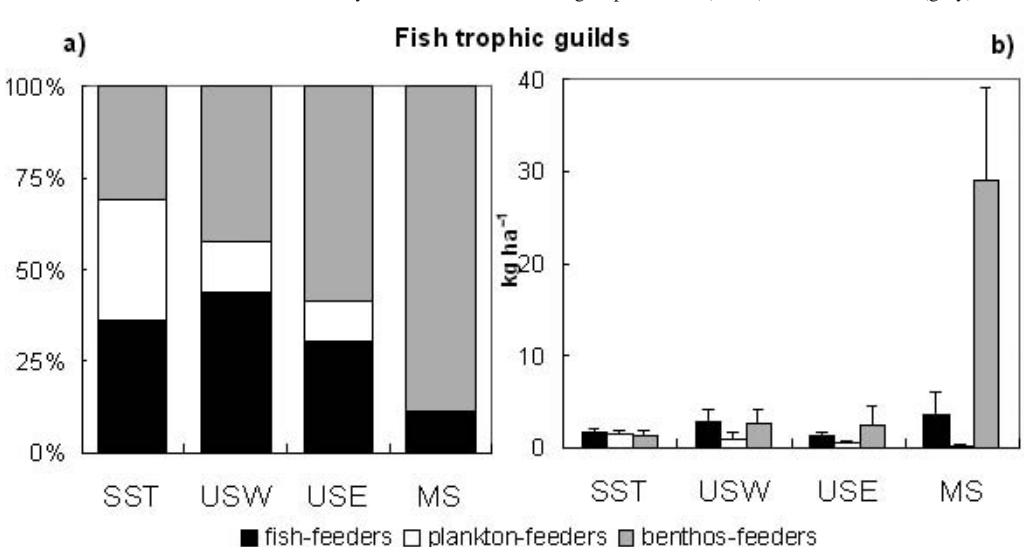
Fig . 5. – Fish species trophic guild composition in the assemblages in terms of biomass percentage (a) and mean biomass